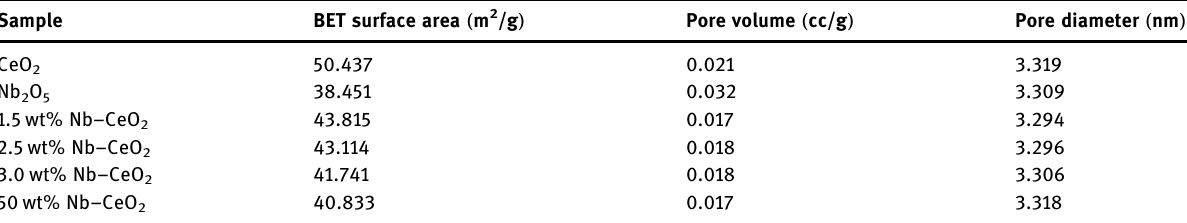
Table 4: BET surface area and pore volume of the catalyst samples Sample